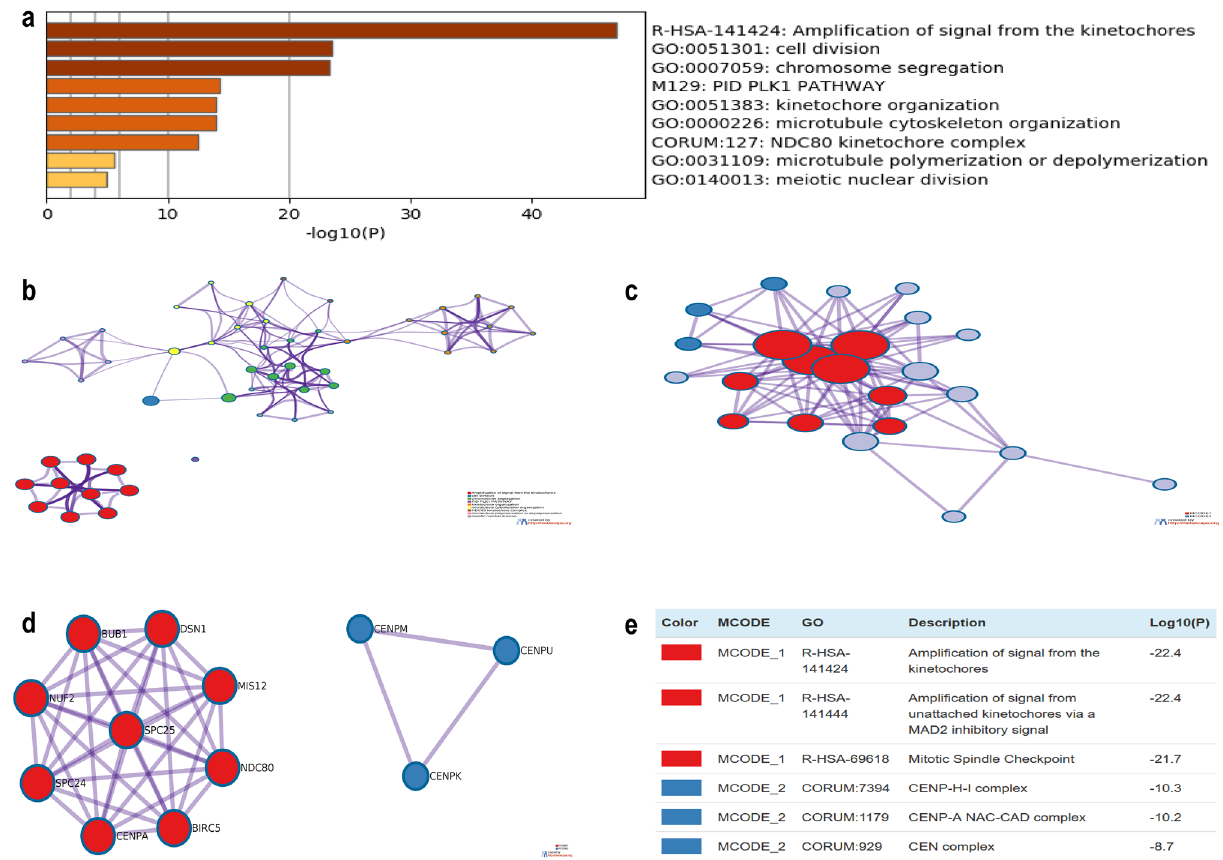
Figure 7. The enrichment analysis of SKAs and the 20 co-expressed genes in HCC patients (Metascape). ( a ) Bar chart of the first nine enriched terms for SKAs and the 20 co-expressed genes. ( b ) Net graph of enriched terms, Different colors represent different cluster ID. ( c , e ) PPI network and MCODE components